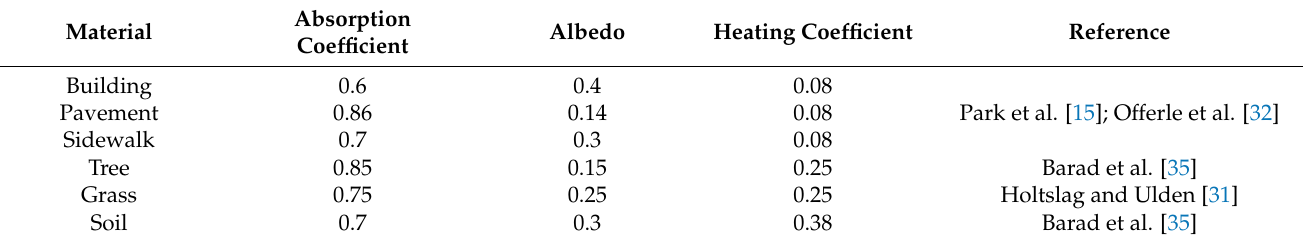
Table 2. Materials table presenting absorption coefficient, albedo, heating